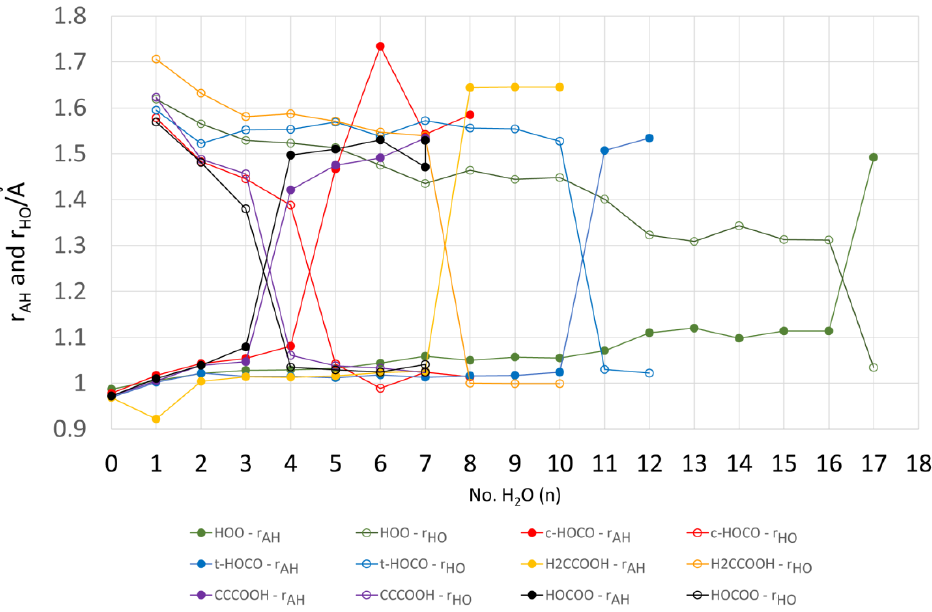
Figure 2. Microhydrated acid radicals (DFT optimized structures): plots of computed distances r AH, and to the nearest water r HO , versus the number of solvating waters ( n ). Data for 4H (HOCOO, black), 1Ht ( t -HOCO, blue), 1Hc ( c -HOCO, red), 3H (H 2 CCOOH, yellow), 2H (CCCOOH, purple), and 5H (HOO, green).